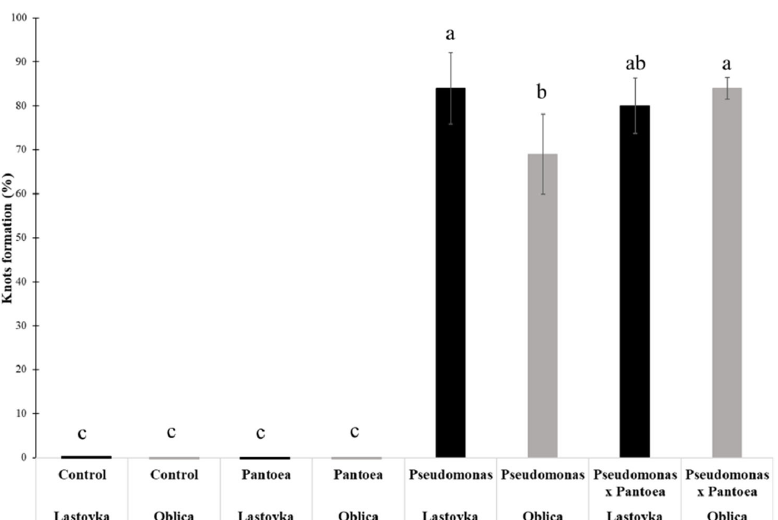
Figure 8. Percentage of knots formation on Oblica and Lastovka cultivars inoculated with Pantoea paga or Pseudomonas ST1 strains used alone or with mixture of two strains compared to non-inoculated control plants. The results are expressed as the means ± SE. Different lowercase letters indicate significant differences according to the least significant difference test at p < 0.05.